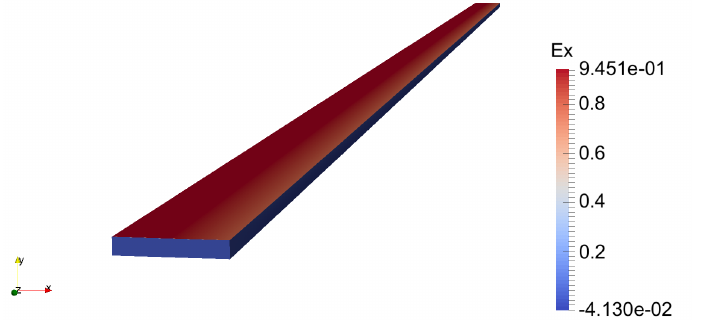
Figure 2. Simulated electric field when the incident field is polarized in the normal direction with respect to the fibers for ω 1 = 2.45 GHz.